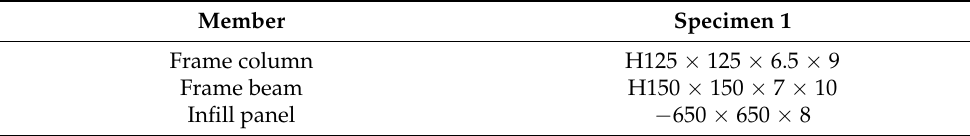
Table 1. The section size of two specimens (units: mm).